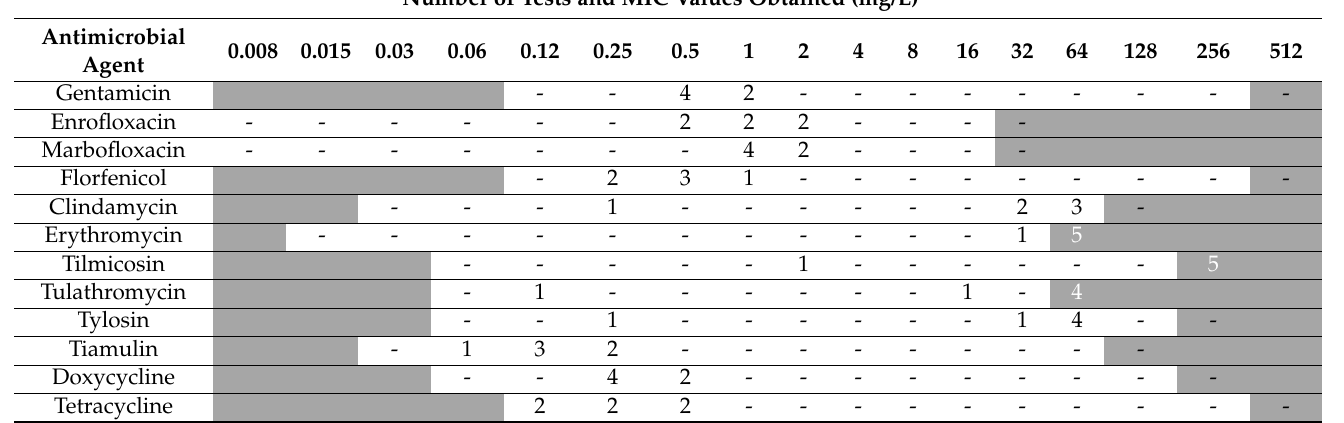
six values per field isolate (a total of 36 values for all field isolates), and the deviations from the mode MIC were determined. Based on the mode MIC, the exact and essential MIC agreements were calculated. For field isolates, the CLSI document M23 dictates an essential MIC agreement of ≥ 90% to evaluate whether a broth medium is suitable [34]. Table 6. Distribution of the MIC values of six M. hyorhinis field isolates using the modified Friis broth. The MIC values represent the mode MICs of three independent tests of each isolate.